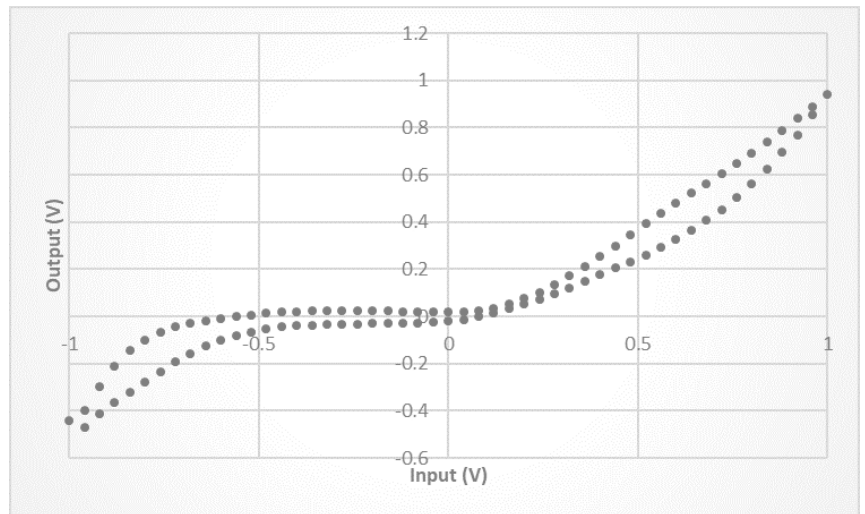
Figure 1. Example of a liquid sample’s electrochemical